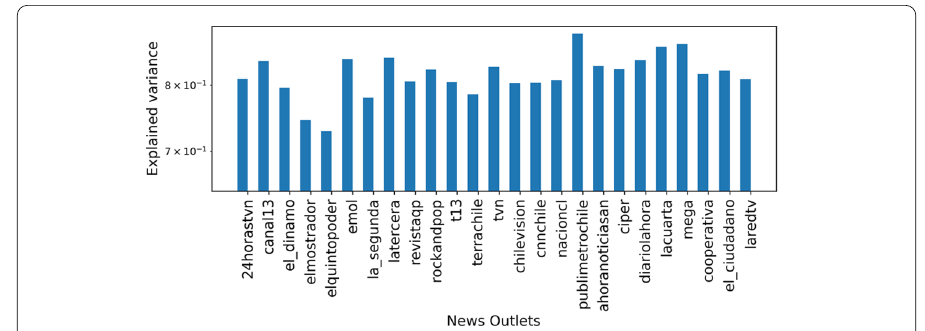
Figure 4 Explained variance using the regressor model for the top 25 news outlets in Santiago